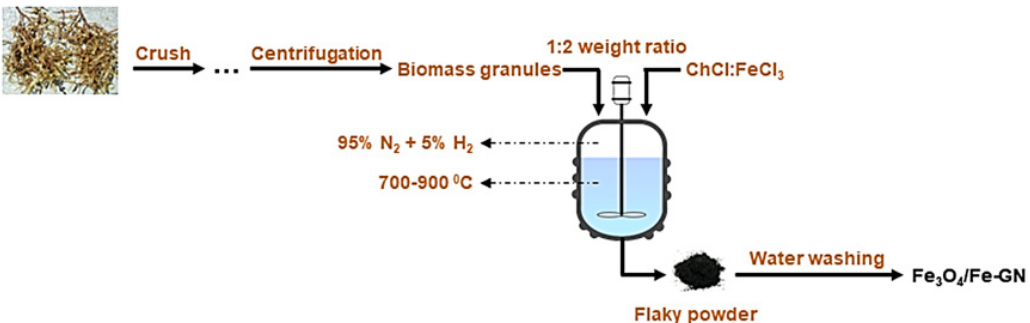
Figure 3. The flowchart for production of Fe 3 O 4 /Fe-GN from Sargassum tenerrimum biomass. The Lewis acid-type DESs have also been employed as catalysts for chemical modi- fications of cellulose to value-added chemicals. For example, Sirvio et al. [79] found that a reactive DES composed of dimethyl-urea and ZnCl 2 (10:3) could be used to synthesize cellulose methyl carbamate (CMeC) at elevated temperature (150 °C). The CMeC had a degree of substitution (DS) of 0.17 after 3 h at 150 °C. The original cellulose fibers had a very poor alkaline solubility, whereas the product with a DS of 0.17 exhibited a good alkaline solubility. In this process, dimethyl-urea degraded to methylamine and methylisocyanate to react with the hydroxyl groups of cellulose. The heat-driven reaction was significantly catalyzed by ZnCl 2 . Figure 4 illustrates the proposed mechanism for CMeC synthesis.